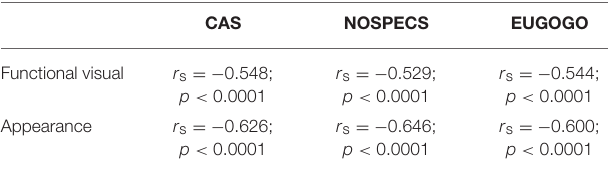
TABLE 4 | Correlation coefficients between QoL domains and questionnaire scores of CAS, NOSPECS, and EUGOGO classifications in go